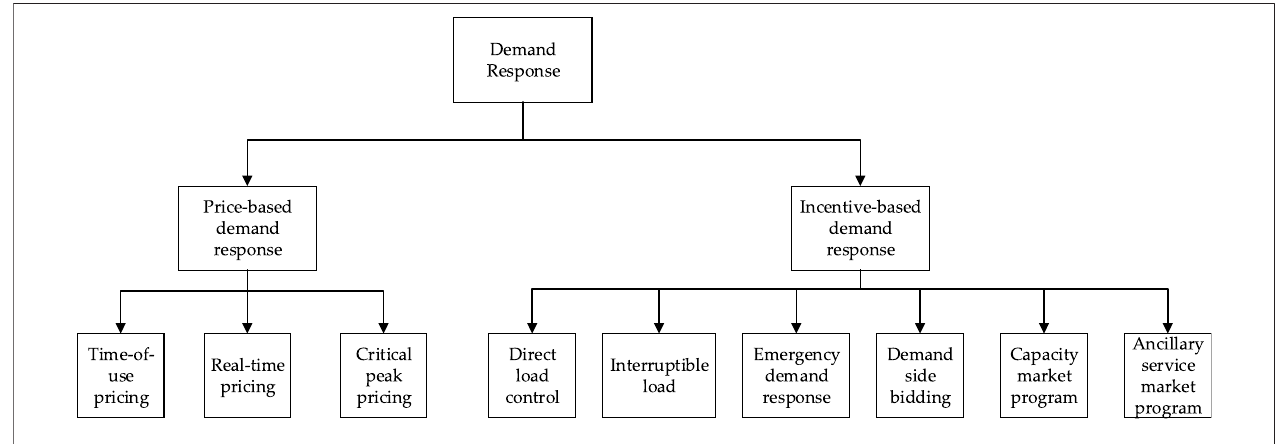
FIGURE 7 | DR classi fi